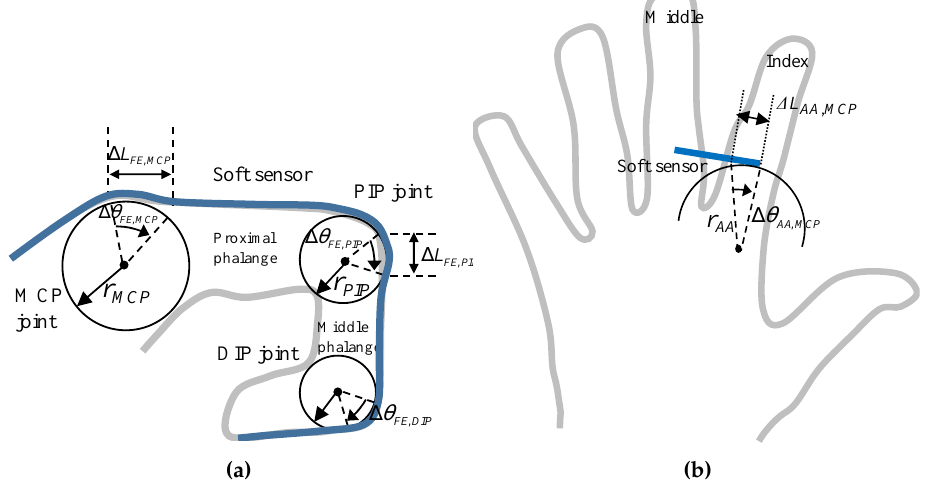
Figure 6. Modeling of the metacarpophalangeal (MCP) and the proximal interphalangeal (PIP) joints; ( a ) Flexion/extension; ( b )